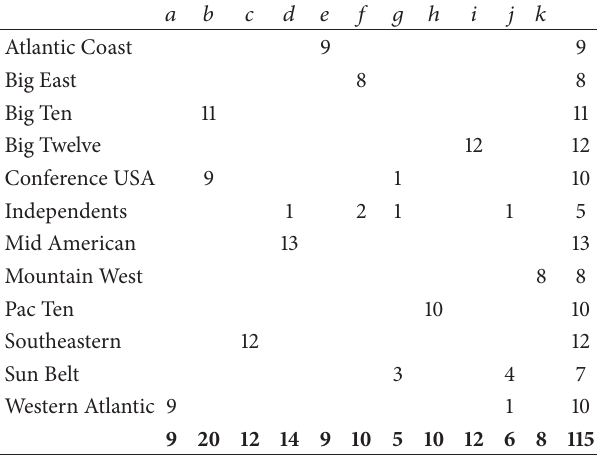
Table 1: The community detection results of our